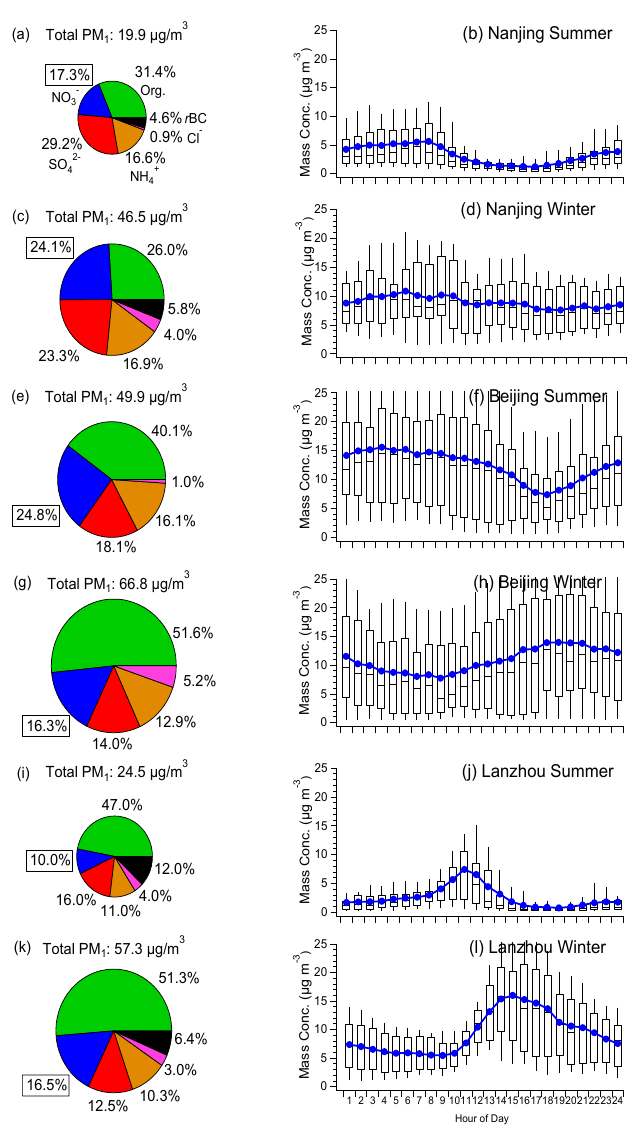
Figure 2. Average fine aerosol particulate matter (PM 1 ) mass loadings, chemical compositions and diurnal variations of the mass concentrations of nitrate: ( a , b ) Nanjing summer, ( c , d ) Nanjing winter, ( e , f ) Beijing summer, ( g , h ) Beijing winter, ( i , j ) Lanzhou summer, and ( k , l ) Lanzhou winter (Beijing datasets did not include refractory black carbon ( r BC); the whiskers above and below the boxes are the 90th and 10th percentiles, the upper and lower boundaries of the boxes are the 75th and 25th percentiles, and the lines in the boxes indicate the median values and the dots indicate the mean values; note Figure 2e–l are reproduced and modified from previous studies [28,29,31,32]).